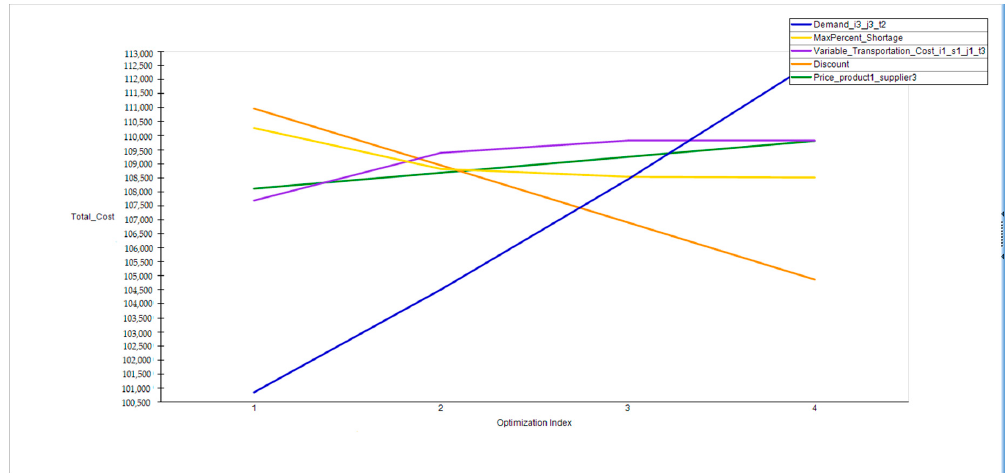
Figure 7. Graphs of the optimal objective value obtained by varying selected parameters one at a time for 4 optimizations (20 runs in total).